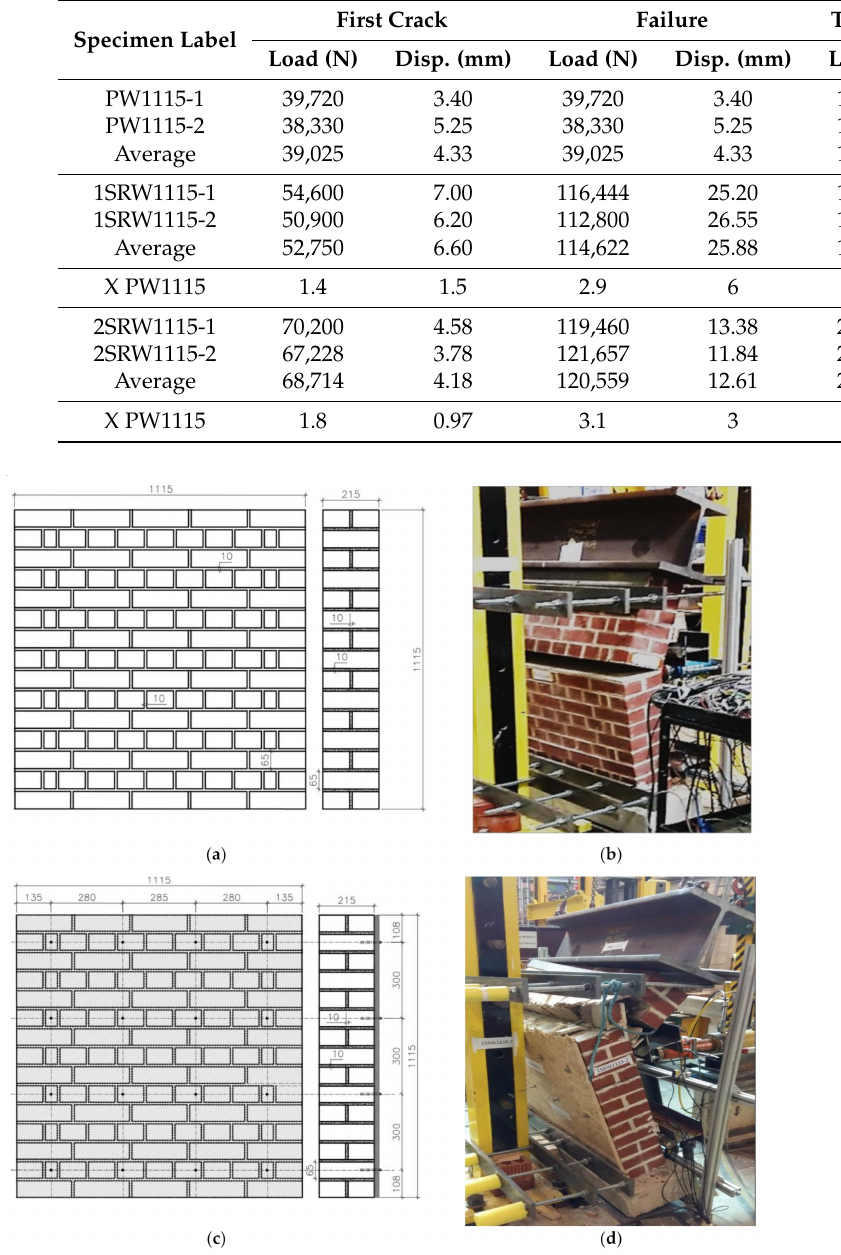
Table 4. Summary of out-of-plane bending test